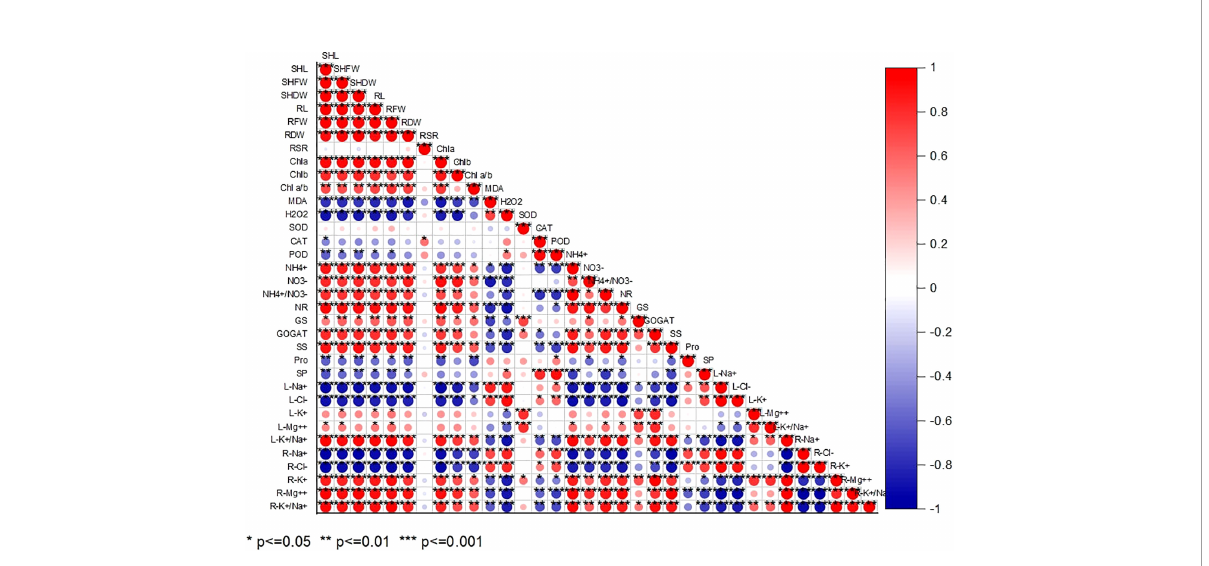
FIGURE 7 Pearson correlation analysis between study parameters in chufa plants under alkaline stress (AS) and exogenous naphthaleneacetic acid (NAA) application. SHL (Shoot lenght), SHFW (Shoot fresh shoot), SHDW (Shoot DW), RL (Root length), RFW (RFW), RDW (Root dry weight), Root-shoot ratio, Chla (Chlorophyll a), Chlb (Chlorophyll b), Chlab (Chlorophyll a/Chlorophyll b ratio), MDA (Malondialdehyde), H 2 O 2 , (Hydrogen peroxide), SOD (Superoxide dismutase), CAT (Catalase), POD (peroxidase), NR (Nitrate reductase), GS (Glutamine synthetase), GOGAT (Glutamine oxoglutarate aminotransferase), SS (soluble sugar), Pro (Proline), SP (Soluble protein), NO − 3 (nitrate), NH + 4 (ammonium), L-Na + (Leaf N), L-Cl - (Leaf Cl - ), L-K + (Leaf K + ) L-Mg ++ (Leaf Mg ++ ), L-K + /Na + ratio (Leaf K + /Na + ratio), R-Na + (Root N + ), R-Cl - (Root Cl - ), R-K + (Root K + ) R-Mg ++ (Root Mg + + ), R-K + /Na + ratio (Root K + /Na +